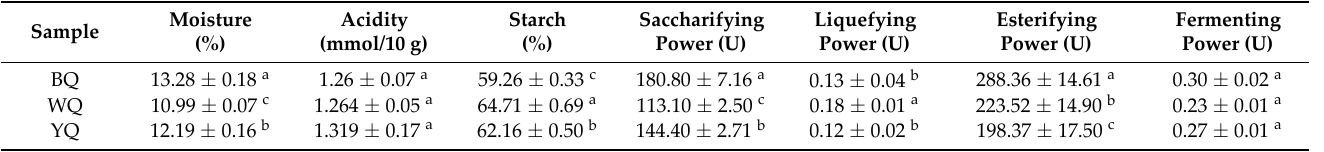
Table 1. Physicochemical index analysis on three Daqu